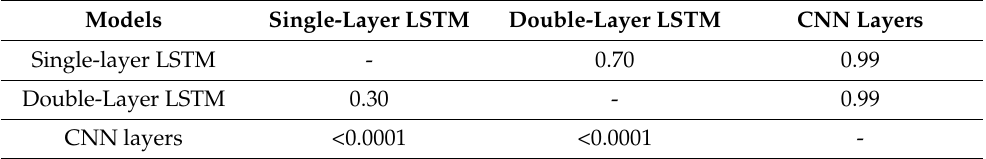
Table 5. Results of the Diebold–Mariano tests for 1 h forecasting accuracy with the null hypothesis that the model in the row predicts more precisely than the model in the